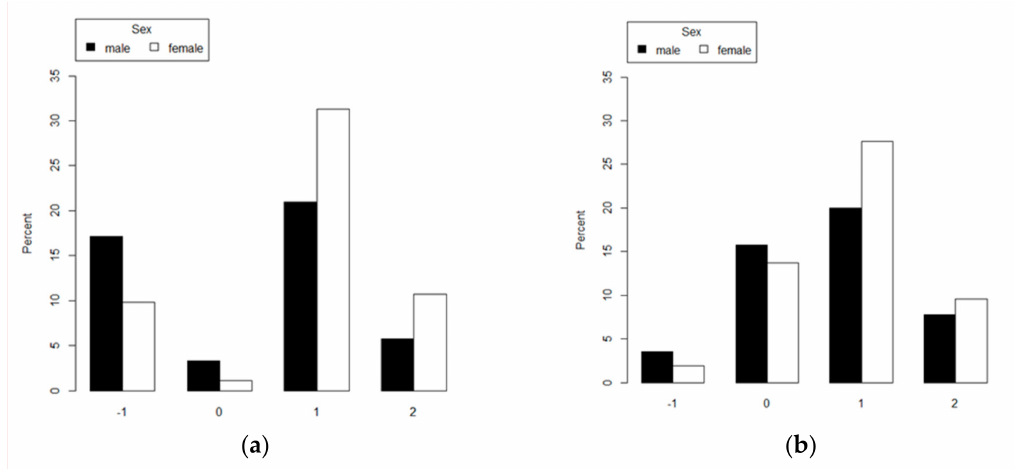
Figure 1. Body size perception and body image (dis)satisfaction, by sex, in elderly participants in the ELSA-Brasil study (2008–2010). ( a ) Body size perception: − 1 = mild and moderate underestimation of body size; 0 = no distortion; 1 = mild overestimation of body size; 2 = moderate and serious overestimation of body size. ( b ) Body image (dis)satisfaction: − 1 = mild and moderate dissatisfaction due to thinness. 0 = satisfaction. 1 = mild dissatisfaction due to excess weight. 2 = moderate and serious dissatisfaction due to excess